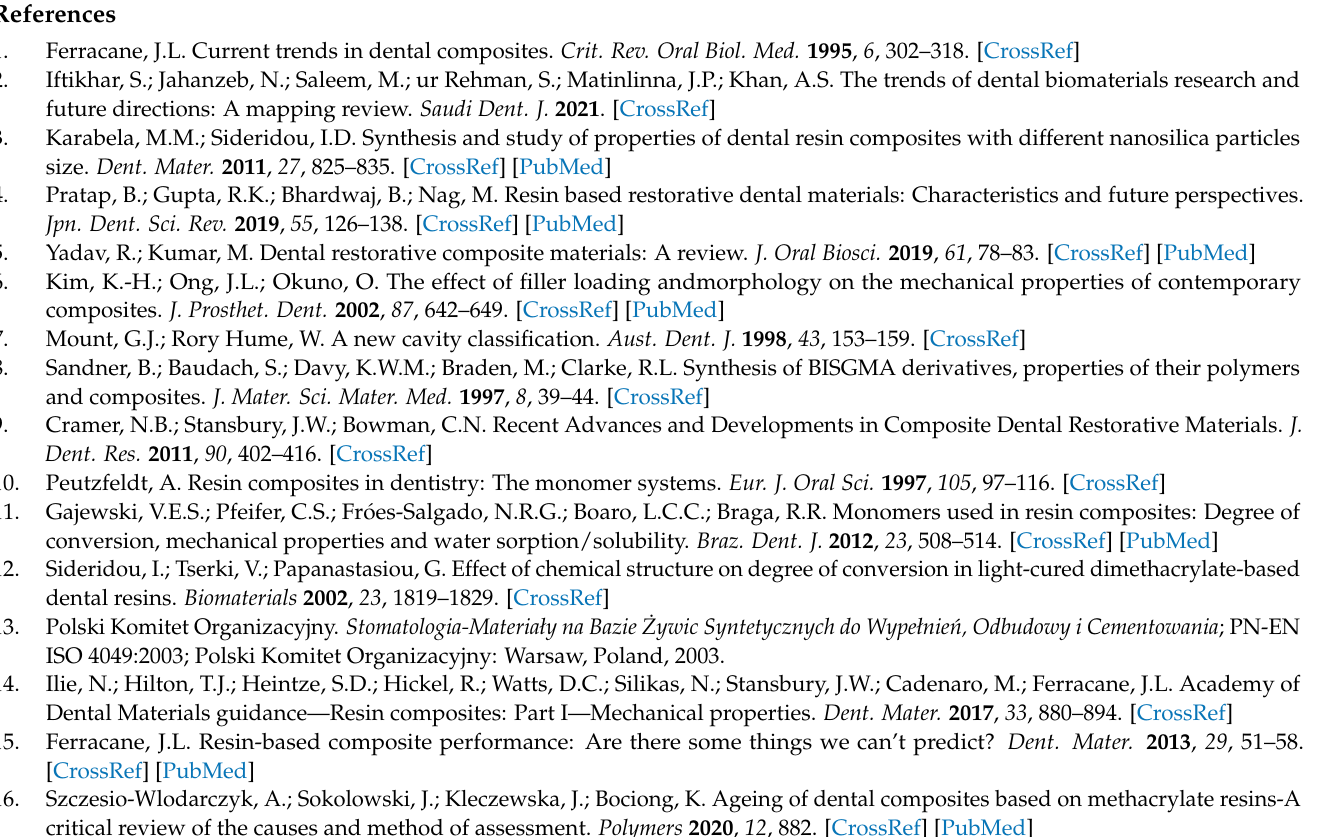
Figure A3. Vickers hardness test.